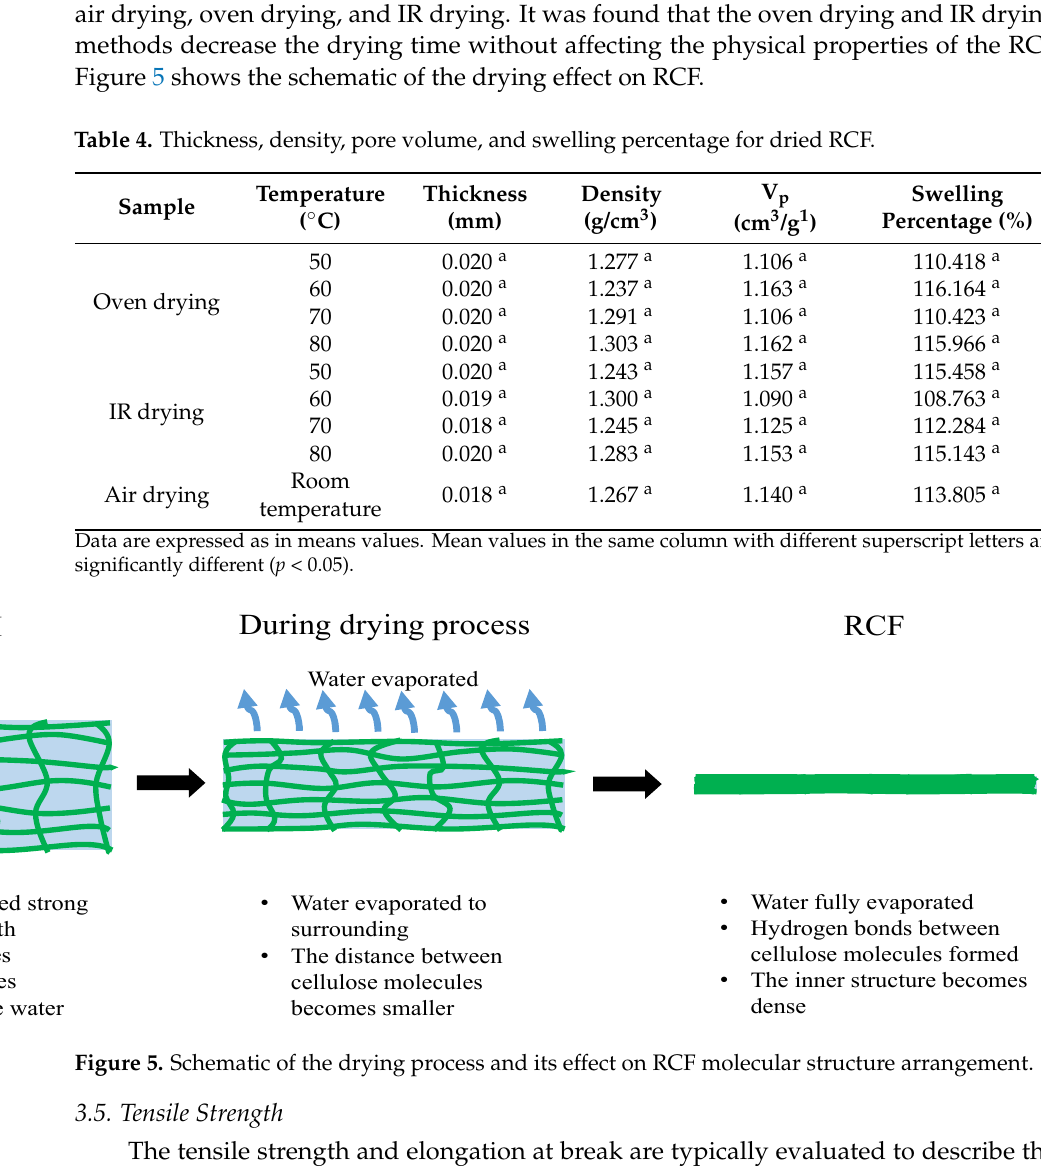
Table 4. Thickness, density, pore volume, and swelling percentage for dried RCF.